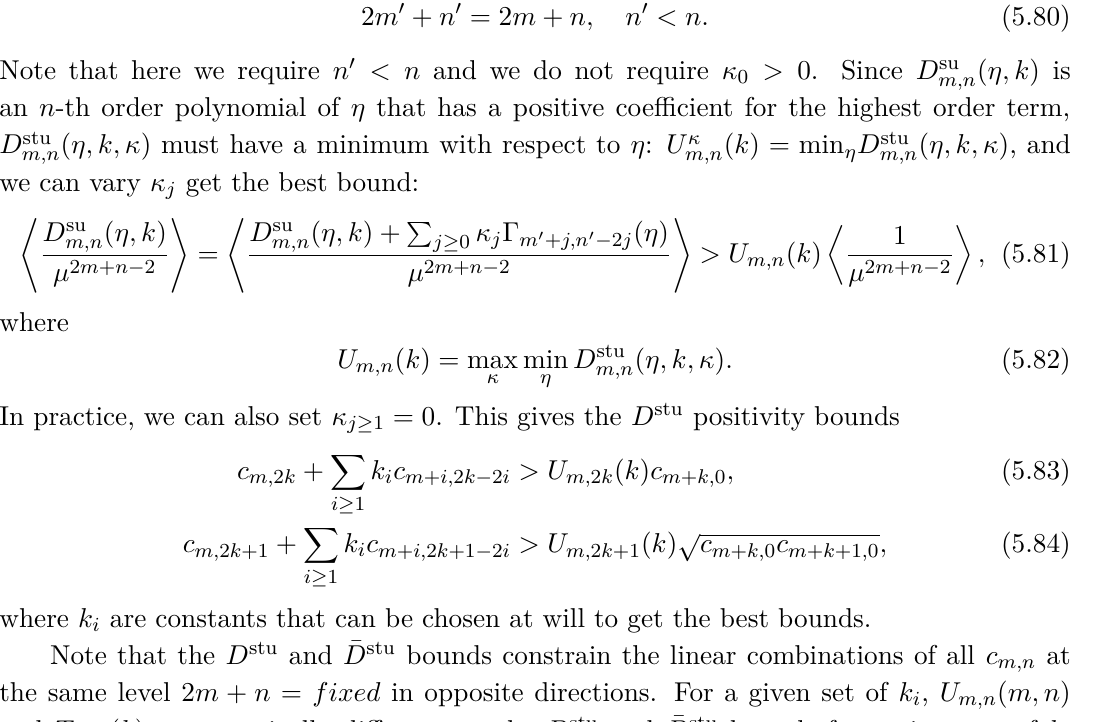
¯ ( η, κ ) in 4D for different η = ‘ ( ‘ + 1) , ‘ = 0 , 1 , 2 , . . . . This convex Figure 1 . Convex hull of D stu 2 , 1 ¯ hull gives T κ = min ( η, κ ) . The maximum of T κ D stu κ 2 , 1 2 , 1 bound (5.74), which is at the intersection point of line ¯ D stu where j runs over all possible s ↔ t constraints at level 1 /µ 2 m + n − 2